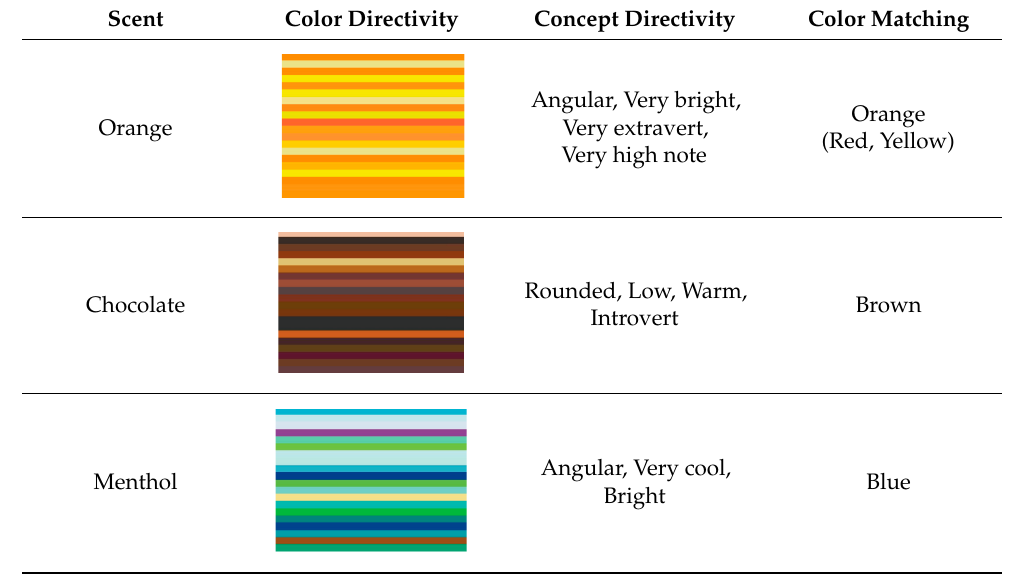
Table 5. Color directivity, concept directivity, and color matching of each scent [89]. Scent